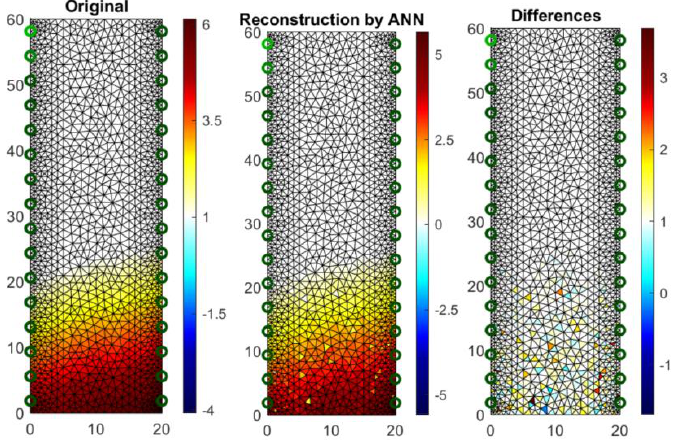
Figure 20. The result of Artificial Neural Network system (ANN) moisture testing of the lightweight concrete block for the case of 2 × 16 electrodes.